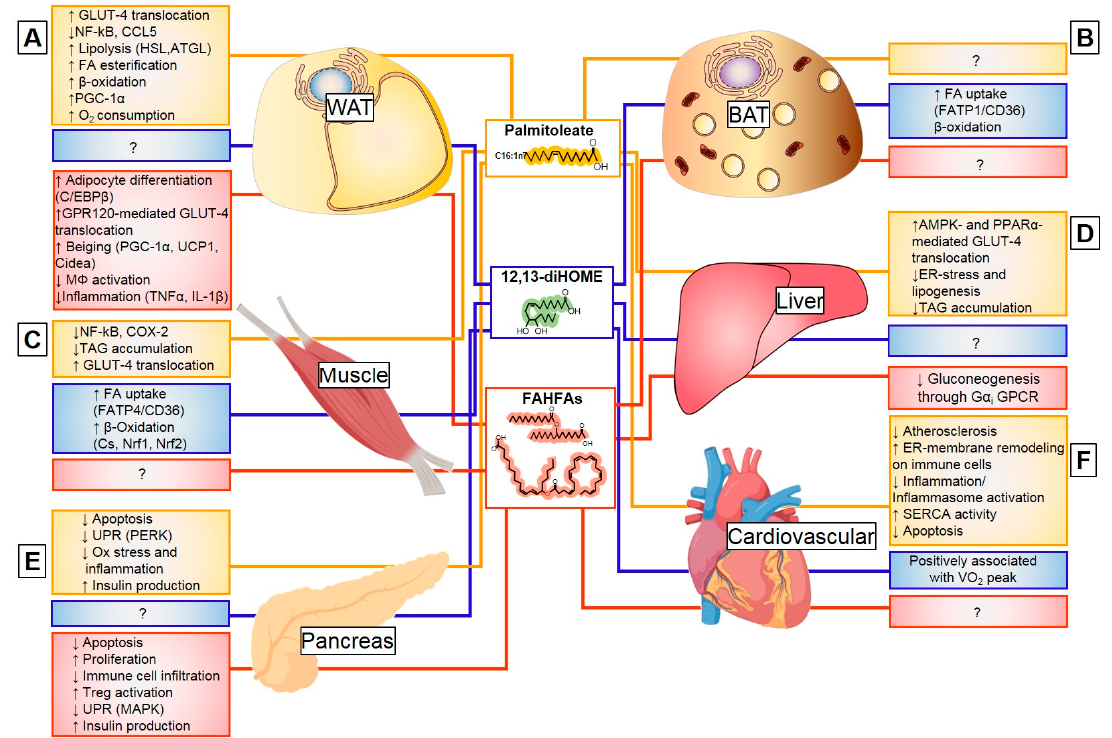
Figure 3. Metabolic targets of lipokines. Lipokines have diverse targets that lead to improved glucose homeostasis and metabolic health. A) In white adipose (WAT), Palmitoleate increases glucose uptake (GLUT4), reduces inflammation (NF-kB), and increases lipolysis of lipid droplets (HSL, ATGL) to provide fuel for β -oxidation, which increases oxygen consumption. While no effects have been described for 12, 13-diHOME in WAT, FAHFAs increase glucose uptake (GLUT4), adipocyte differentiation, decrease inflammation, and promote beiging. B) In brown adipose (BAT), the only known effect of lipokines is for 12, 13-diHOME , where it contributes to cold-induced adaptation by increasing the uptake of FA and enhancing β -oxidation. C) In skeletal muscle, Palmitoleate ameliorates inflammation and oxidative stress, while decreasing intramyofibrillar TAG deposition and improving glucose uptake (GLUT4). On the other hand, 12, 13-diHOME is a strong effector of muscle function. It is the main driver of the physiological adaptation to exercise by increasing the uptake of FA and enhancing β -oxidation. No effects are known for FAHFAs. D) In the liver, the only documented effect by a lipokine is for Palmitoleate, where it increases glucose uptake, decreases stress, and reduces steatosis by downregulating lipogenesis. E) Pancreatic function is improved by both palmitoleate and FAHFAs and increases insulin production. Both lipokines modulate apoptosis, oxidative stress, and the unfolded protein response (UPR). PAHSAs modulate immune cell infiltration in a model of type 1 diabetes. No effects are known for 12, 13-diHOME . F ) Cardiovascular improvements are observed with both palmitoleate and 12, 13-diHOME . Palmitoleate is associated with a reduction in atherosclerosis driven by immune-cell endoplasmic reticulum membrane lipid remodeling that results in reduced inflammation. Furthermore, the SERCA pump is improved with palmitoleate administration, which contributes to functional improvements. 12, 13-diHOME appears to be positively correlated with cardiometabolic fitness or VO2 peak, but no studies have assessed the influence on cardiovascular function. No effects are known for FAHFAs.